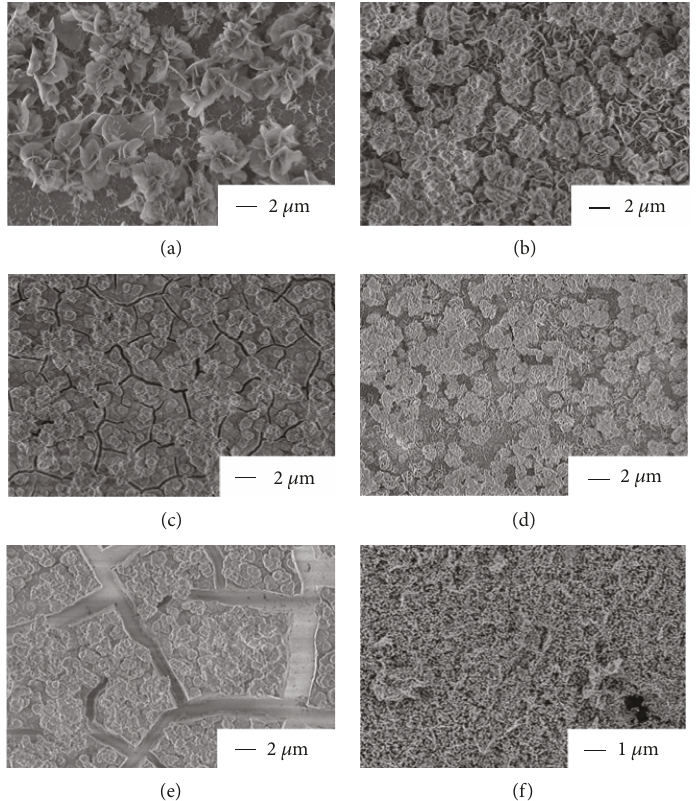
Figure 4: SEM micrographs of ZnO coatings deposited in di ff erent aqueous nitrate baths with various Al percentage, namely, (a) ZnO electrolyte, (b) 1at.% of aluminum, (c) 2at.% of aluminum, (d) 4at.% of aluminum, (e) 6at.% of aluminum, and (f) 10at.% of aluminum.